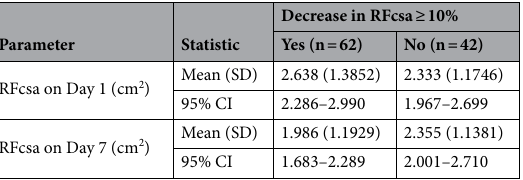
Table 2. Measurement of rectus femoris cross-sectional area